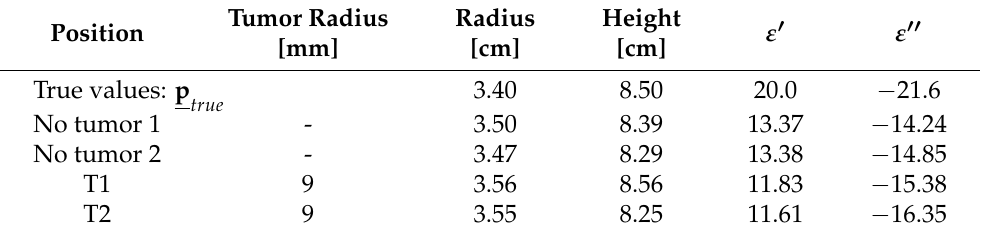
Table 5. Summary of fibroglandular region parameter predictions for calibrated experimental